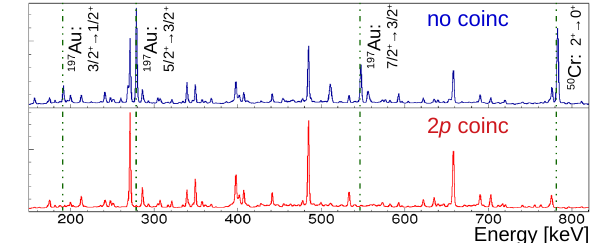
Figure 1. Comparison between the spectra in coincidence with two protons (bottom) and the total γ spectrum (top) detected at 152 ◦ with a target-stopper distance of 10 µ m. The suppression of the Coulomb excitation events between the 50 Cr beam and the 197 Au stopper are shown.